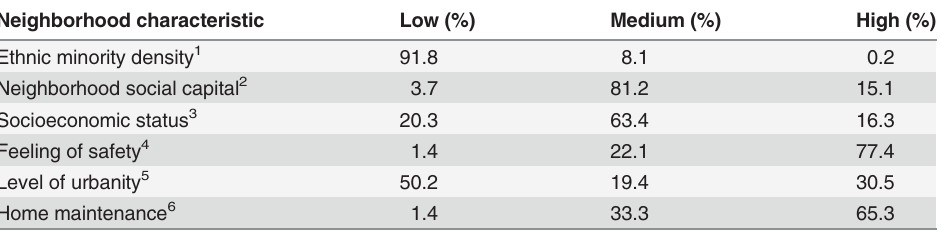
Table 3. Descriptive statistics of the